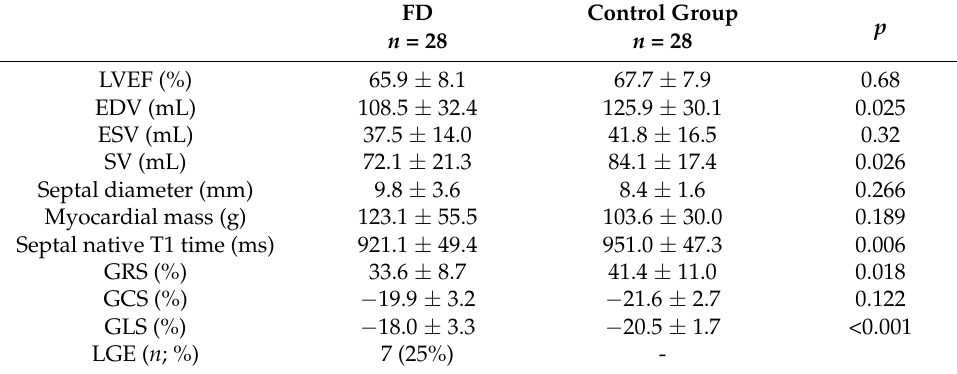
Table 2. Cardiac function and morphology: FD versus control group.